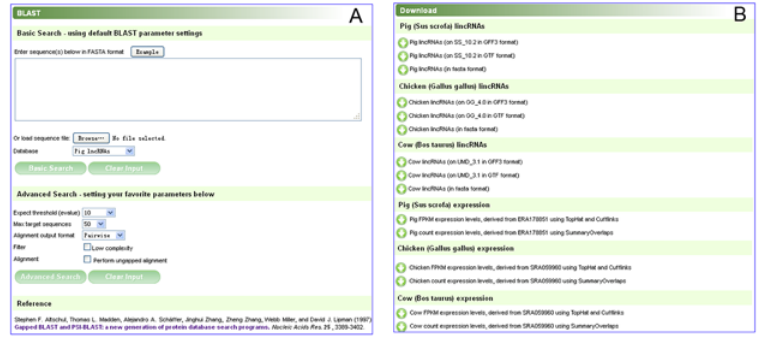
Fig 5. Screenshot of the BLAST and download pages. (A) The BLAST page. (B) The download page.